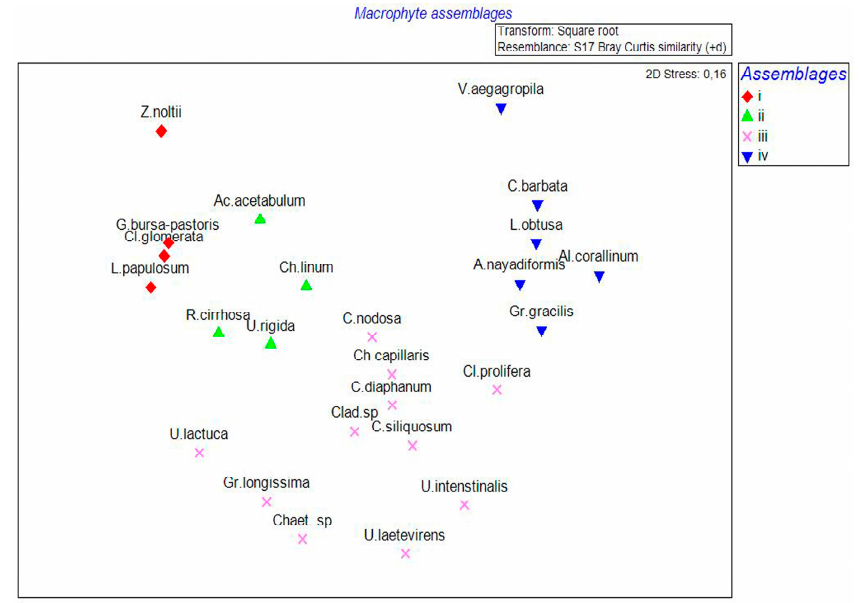
Figure 5. Results of Multidimentional Scaling (MDS) analysis of macrophyte assemblages identified in the three different lagoon types of Western